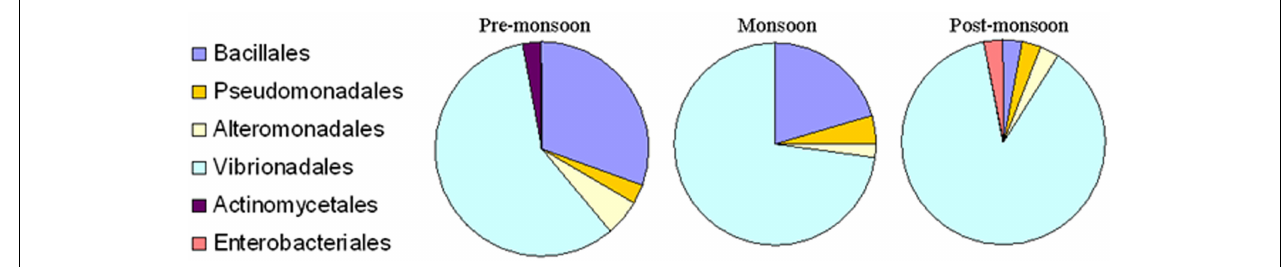
FIGURE 4 | Bacterialisolation.(A) Enumerationofbacteriafromdifferentmacroalgalsamplessuchas Ulvafasciata , U . lactuca , Gracilariadura and G . corticata . (B) Small plantlets of macroalgae were placed on the different culture media for isolating bacteria from them. Bars indicate, deviation of three independent replicates.